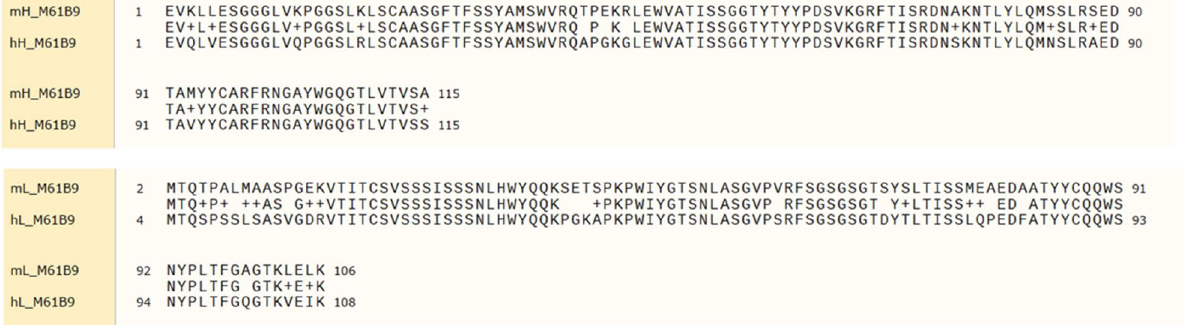
Figure 2. Alignment result of mouse ScFvM61B9 (mouse light chain; mL and mouse heavy chain; mH) against HuScFvM61B9 (human light chain; hL and human heavy chain; hH).